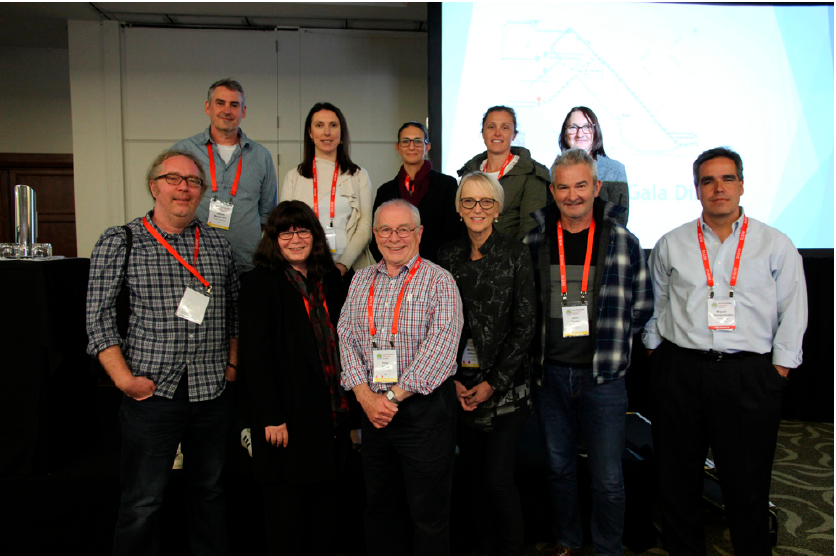
Figure 5. “Successfully transitioning from post-doc to lab head” career development session. Panel members from left to right: Dr. Michelle Tate, Dr. Kirsty Short, Professor Heidi Drummer (moderator), Professor Vernon Ward and Professor Allison Abendroth.